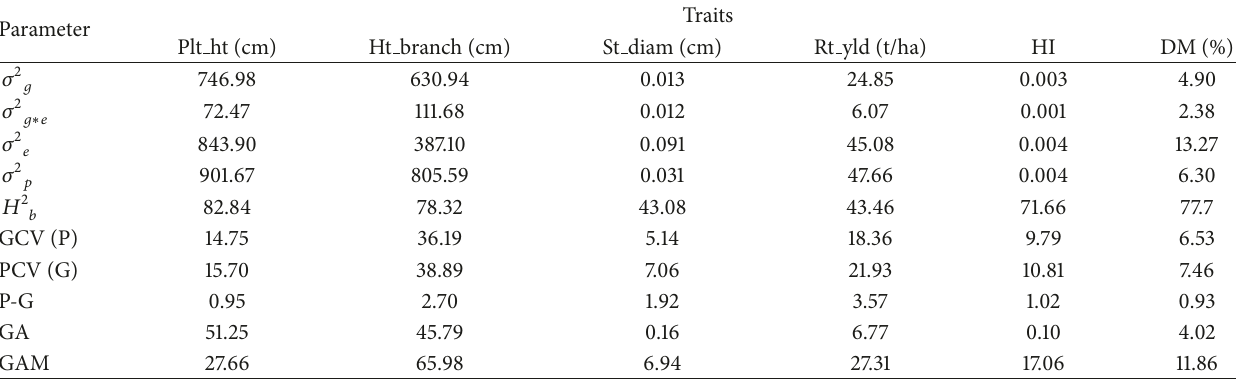
Table 5: Estimates of variance components, broad sense heritability, PCV, and GCV for six traits in 20 cassava genotypes from four